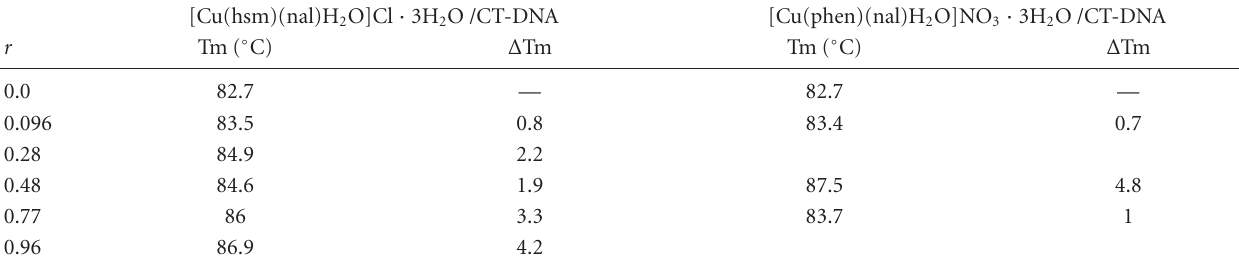
Table 2: Expermental melting temperatures (Tm) and di ff erence with the CT-DNA Tm ( Δ Tm) values as determined from the thermal denaturation profiles of CT-DNA and its interactions with the [Cu(hsm)(nal) H 2 O]Cl · 3H 2 O or [Cu(phen)(nal)H 2 O]NO 3 · 3H 2 O